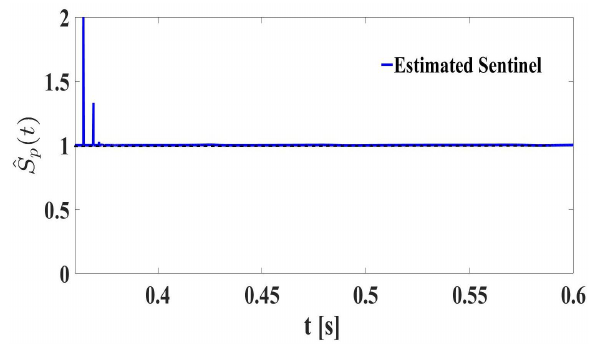
Figure 14. Convergence of the sentinel parameter.